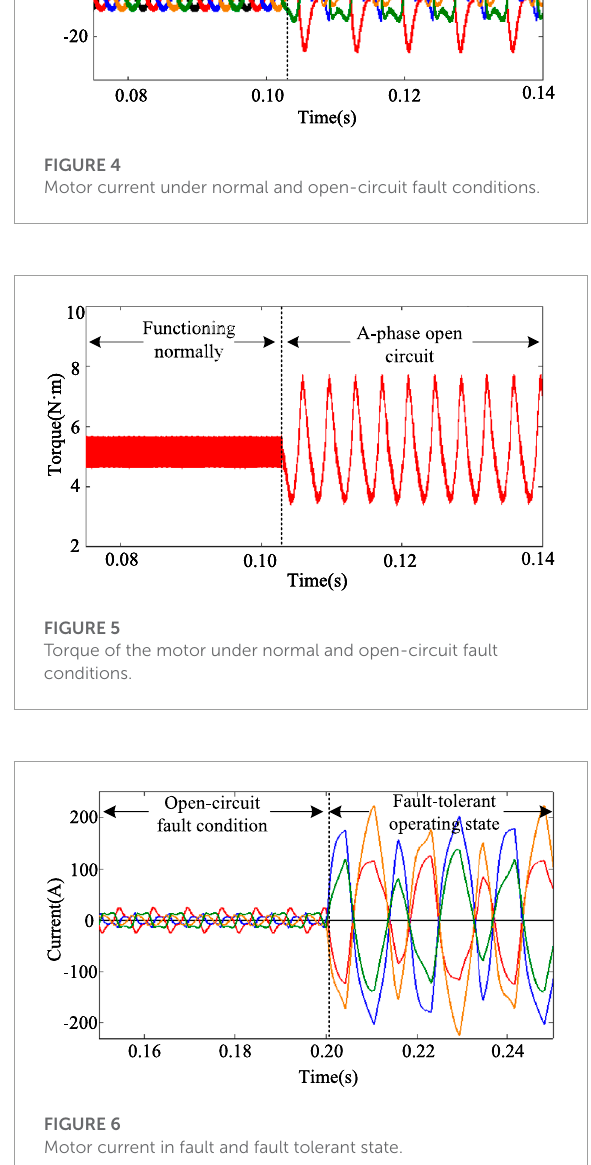
FIGURE 6 Motor current in fault and fault tolerant